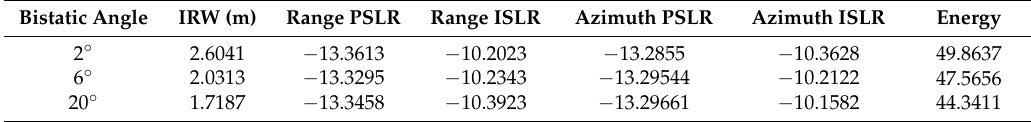
Figure 19. The simulation results for 20° bistatic angle with the consideration of the TCR optimum boresight. ( a ) The point target image after upsampling 48 times; ( b ) the azimuth profile based on the results of the electromagnetic simulation. Table 3. Image quality analysis parameters of the TCR.